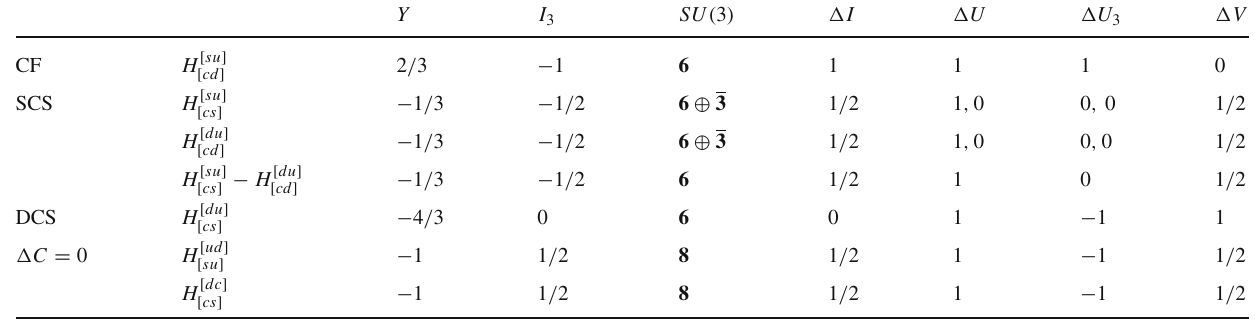
Fig. 2 Weight diagrams of the sextet (left) and antitriplet (right) representation of the effective weak Hamiltonian. The locations of the CF, SCS and DCS transitions are marked by a circle dot symbol